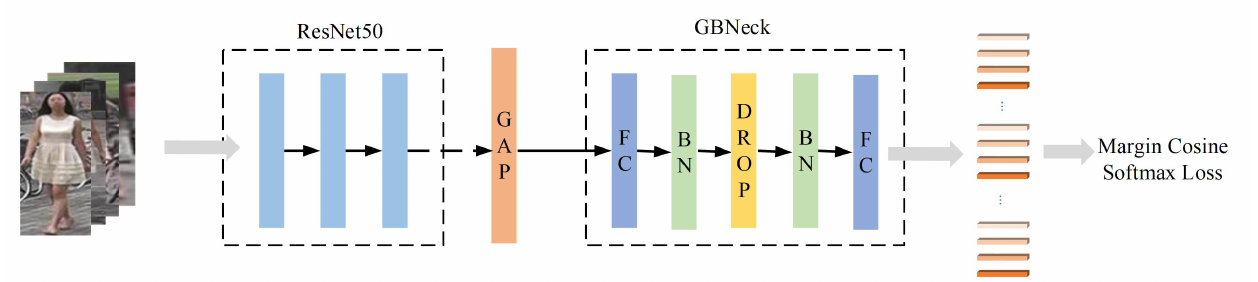
Figure 1. The framework of the proposed margin CosReid network. The first dotted box is the basic skeleton of ResNet50 for dataset feature extraction, in which the blue bars represent the residual structure. Then, the global average pooling (GAP) layer is introduced. The second dotted box is the proposed GBNeck module. Finally, 512-dimensional feature vectors are obtained and inputted into the loss function for the final